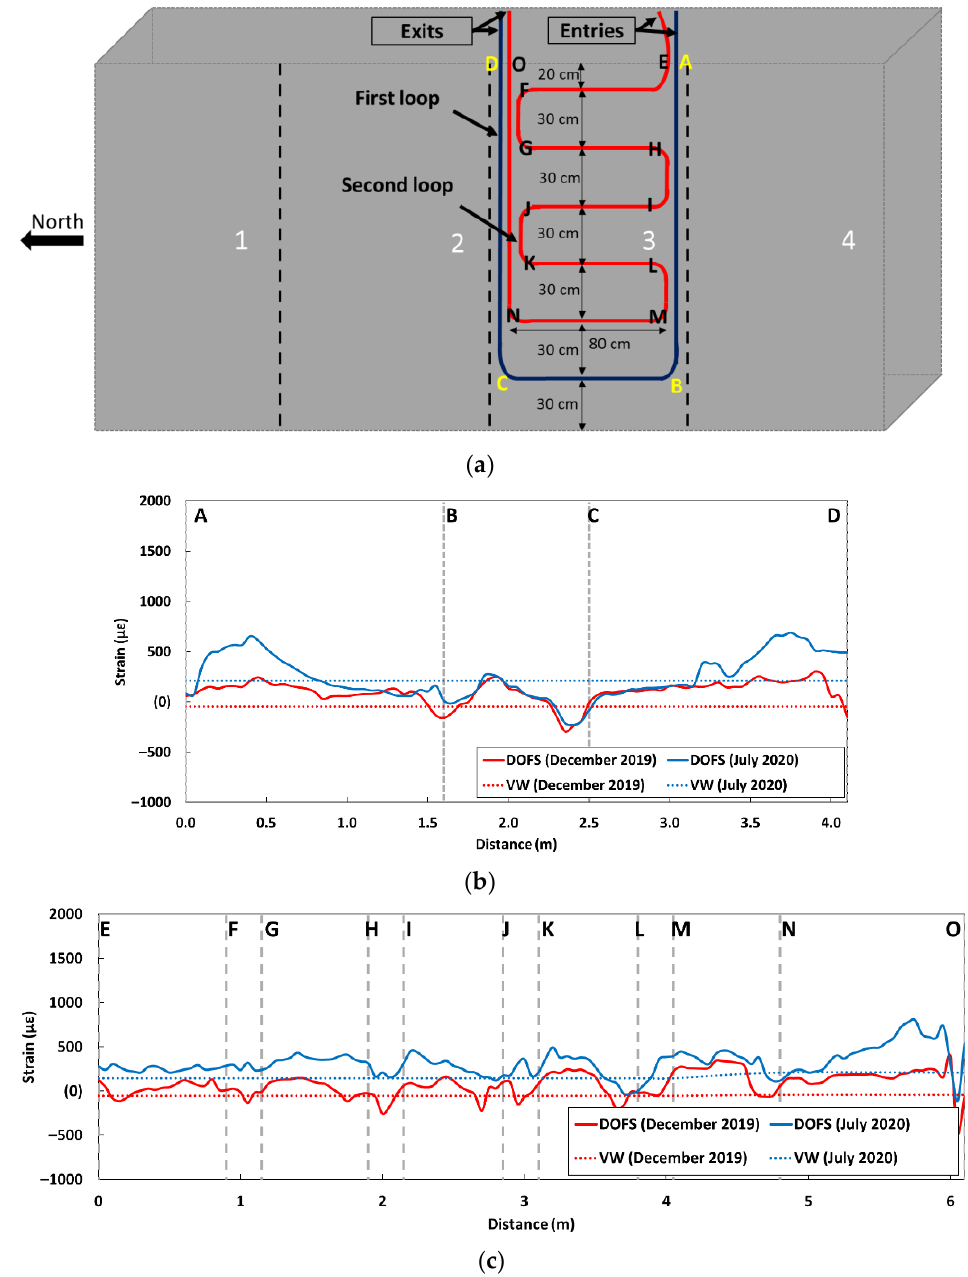
Figure 16. ( a ) Instrumentation scheme of the block KB with bonded DOFS, in which segments of the two DOFS loops are identified with alphabet letters; Strain profiles along the first loop ( b ) and the second loop ( c ) of the bonded DOFS cable (solid lines), together with the strain data from the nearest VWs (dotted lines).